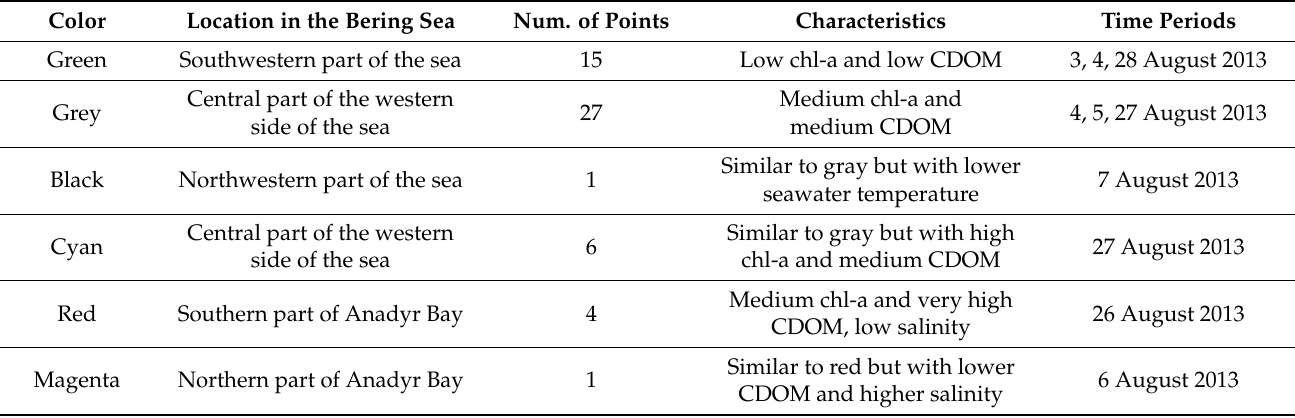
Figure 5. Remote sensing and in situ measurements of bio-optical and hydrophysical parameters in the Bering Sea: ( a ) spectral remote sensed reflectance measured above the water; ( b ) scatterplot of flow-through measurements of seawater temperature and salinity in Practical Salinity Units (PSU); ( c ) scatterplot of flow-through measurements of “optically weighted” chl-a concentration and CDOM content; ( d ) scatterplot of flow-through measurements of “optically weighed” CDOM content and seawater salinity. Table 3. Summary of the selected water